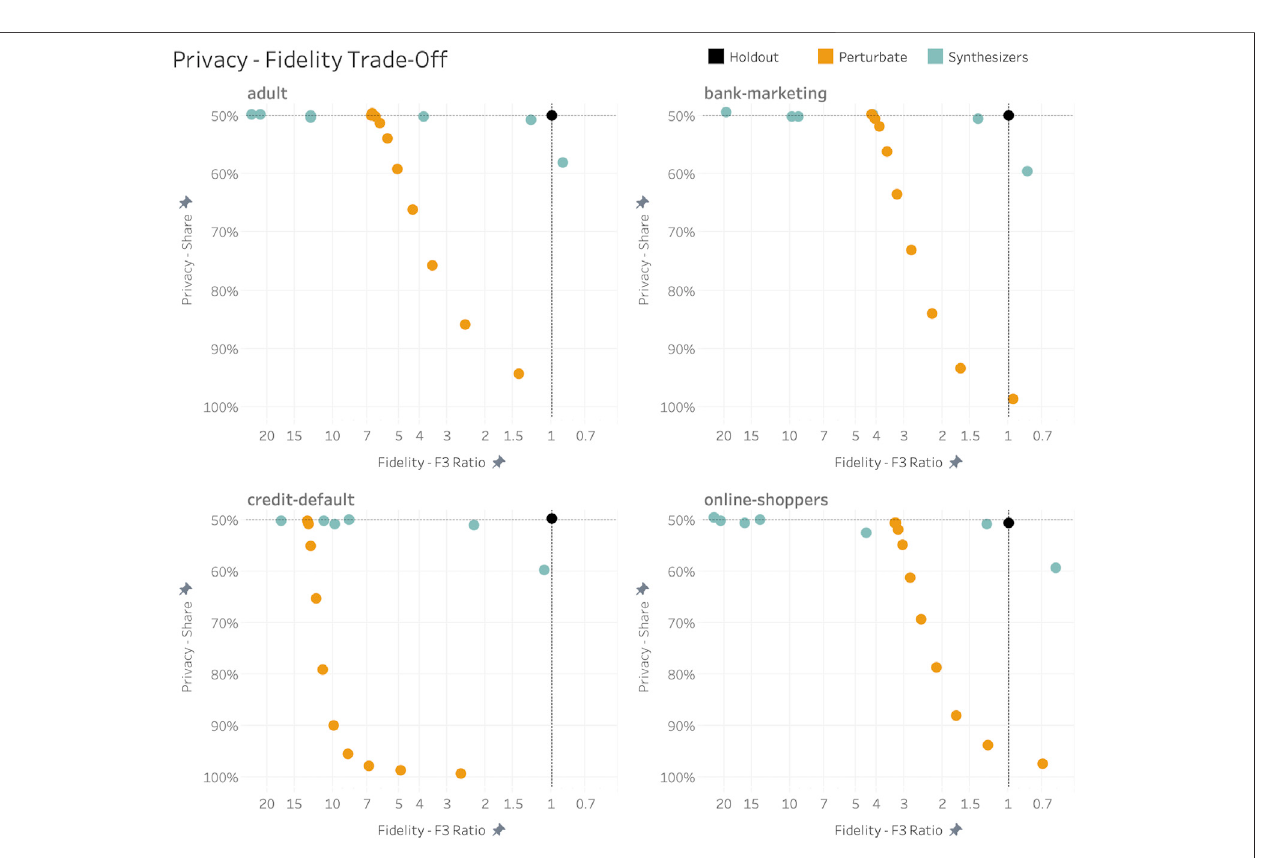
Frontiers in Big Data |